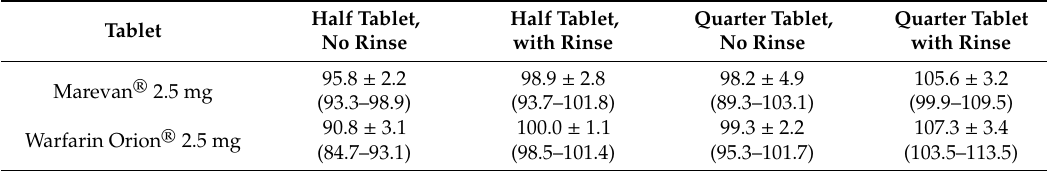
Table 4. Dispersing a fragment: Per cent recovered for fragments of warfarin tablets dispersed in a